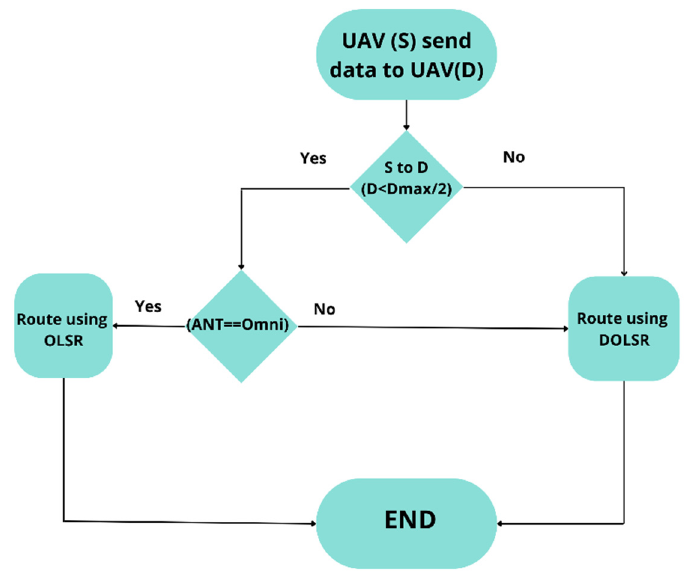
Figure 3. Flowchart of the D-OLSR mechanism, where S—Source and D—Destination.